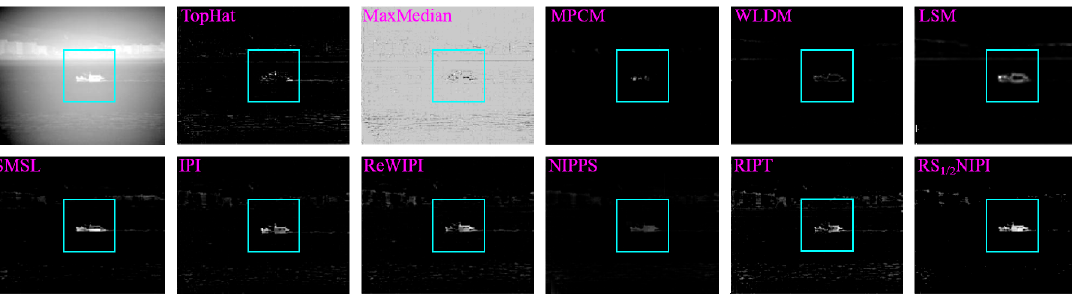
Figure 16. An example of structurally sparse target scenes and the corresponding detection results obtained by the proposed method compared with ten competitive methods.